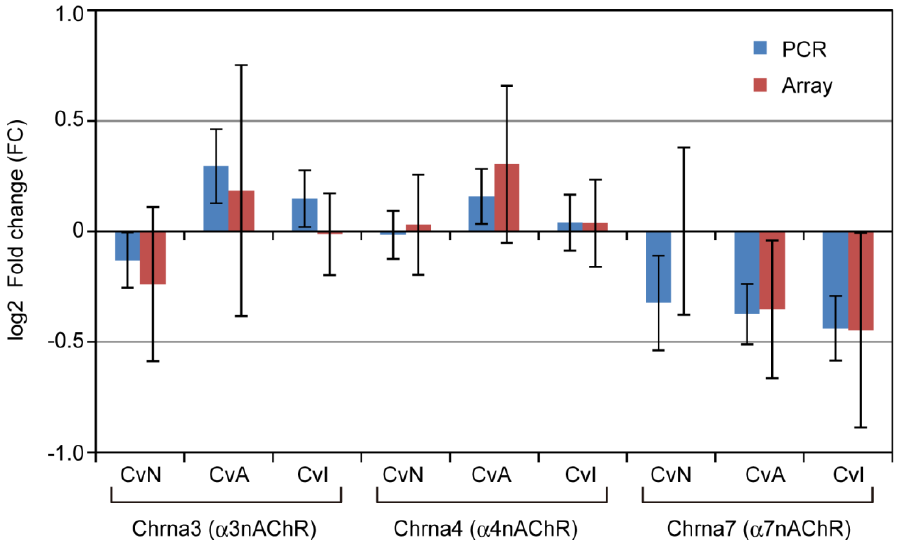
Figure 6. Relative mRNA expression of three nAChRs in cerebellar cultures exposed to nicotine, acetamiprid or imidacloprid for 14 days, at 16 days in vitro, versus control, measured using qRT-PCR and microarray. Error bars represent standard error of six independent experiments. T -tests showed no significant differences in expression between PCR and microarray, or between control versus nicotine (CvN), acetamiprid (CvA), or imidacloprid (CvI).